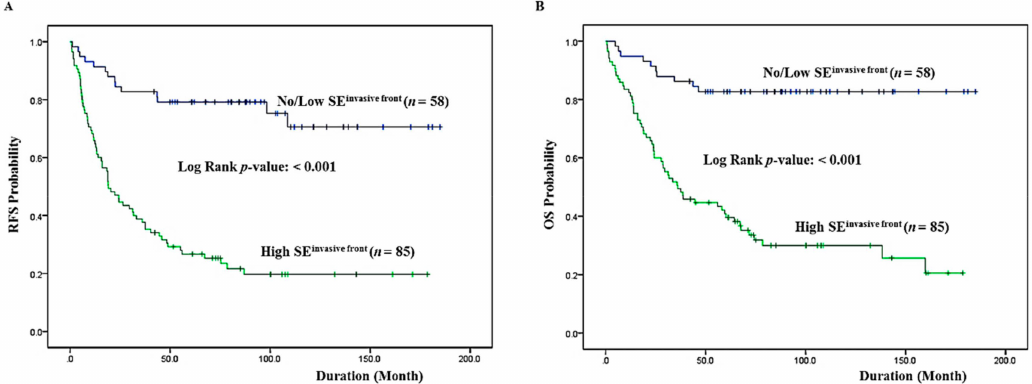
Figure 3. Kaplan–Meier survival analysis by SE expression status at the invasive front. ( A ) Cumulative RFS di ff erences between patients with high and low SE expression. ( B ) Cumulative OS di ff erences between patients with high and low SE expression. The p -value was obtained using the log-rank test of the di ff erences. RFS: recurrence-free surviva; OS: overall